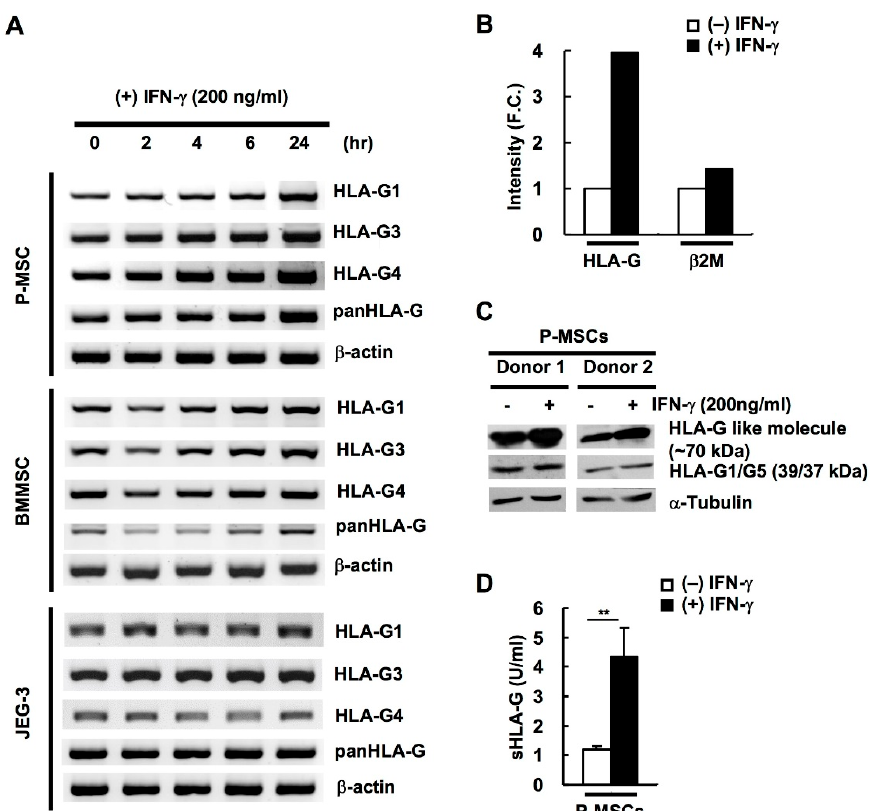
Figure 2. HLA ‐ G expression in human MSCs but not JEG ‐ 3 cells is responsive to interferon ‐γ (IFN ‐γ ) Figure 2. HLA-G expression in human MSCs but not JEG-3 cells is responsive to interferon- γ (IFN- γ ) stimulation. ( A ) Expression of HLA ‐ G transcripts (HLA ‐ G1, G3, and G4) in IFN ‐γ‐ treated BMMSCs, stimulation. ( A ) Expression of HLA-G transcripts (HLA-G1, G3, and G4) in IFN- γ -treated BMMSCs, P ‐ MSCs, and JEG ‐ 3 cells at 0, 2, 4, 6, and 24 h as analyzed by nested PCR. β‐ actin was used as an P-MSCs, and JEG-3 cells at 0, 2, 4, 6, and 24 h as analyzed by nested PCR. β -actin was used as an internal control. Protein levels of various HLA ‐ G isoforms in P ‐ MSCs with or without IFN ‐γ treatment internal control. Protein levels of various HLA-G isoforms in P-MSCs with or without IFN- γ treatment (200 ng/mL) as detected by ( B ) tandem mass spectrometric (MS/MS) analysis, ( C ) Western blot (200 ng / mL) as detected by ( B ) tandem mass spectrometric (MS / MS) analysis, ( C ) Western blot analysis, analysis, and ( D ) ELISA. ** p < 0.01. and ( D ) ELISA. ** p < 0.01.